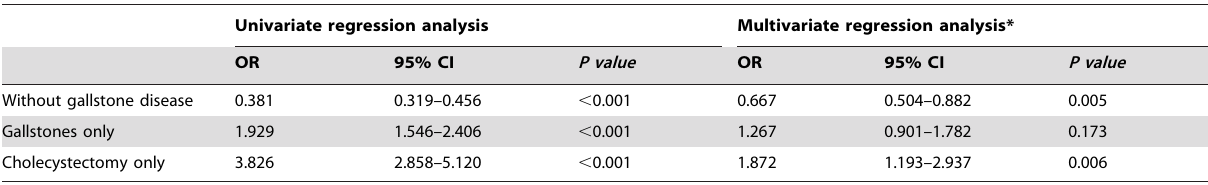
Table 2. Logistic regression analysis of odds ratios for the metabolic syndrome relative to gallstone